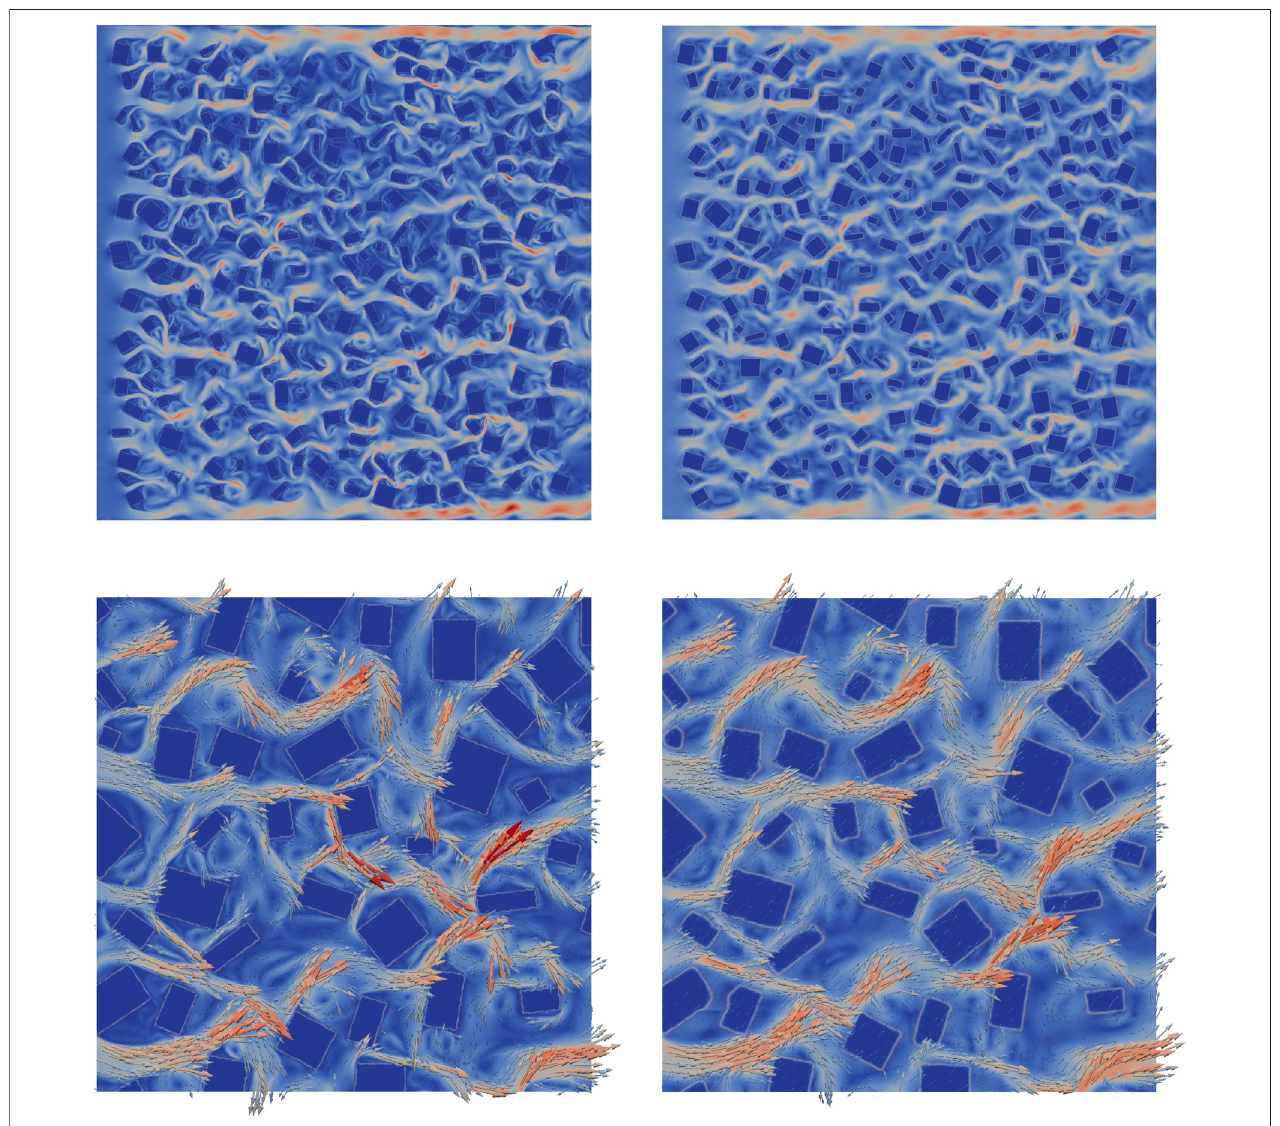
FIGURE 10 | Velocity magnitude across the 9 by 9 domain at time level 250. Top left: HFM, and top right: prediction by the ROM. Bottom left and right: velocity vectors over a 3 by 3 region [1,4]×[4,7] of the 9 by 9 domain, for HFM and NIROM respectively.